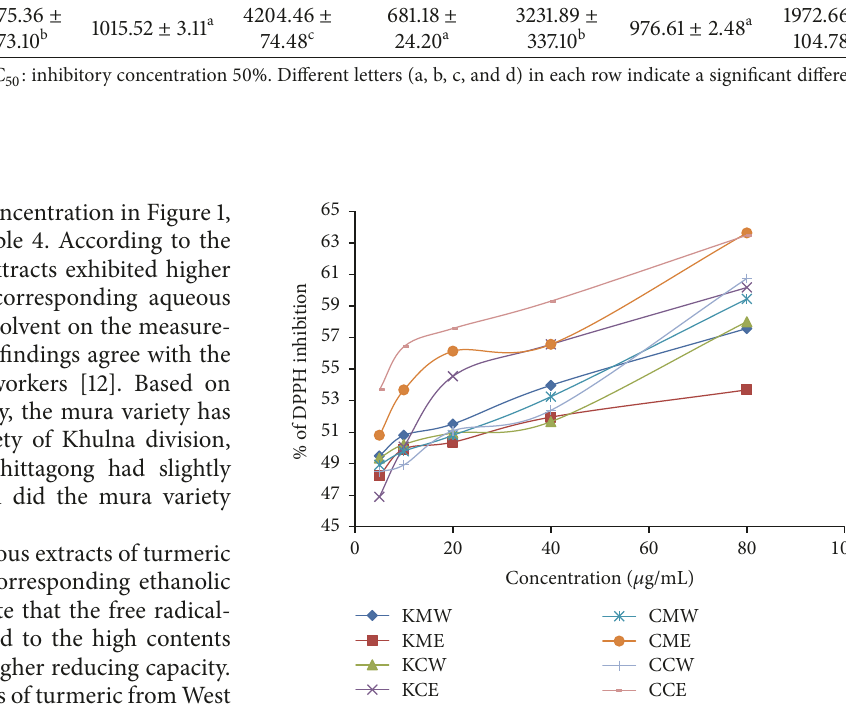
Figure 2: Percentage of DPPH inhibition for different turmeric extracts at different